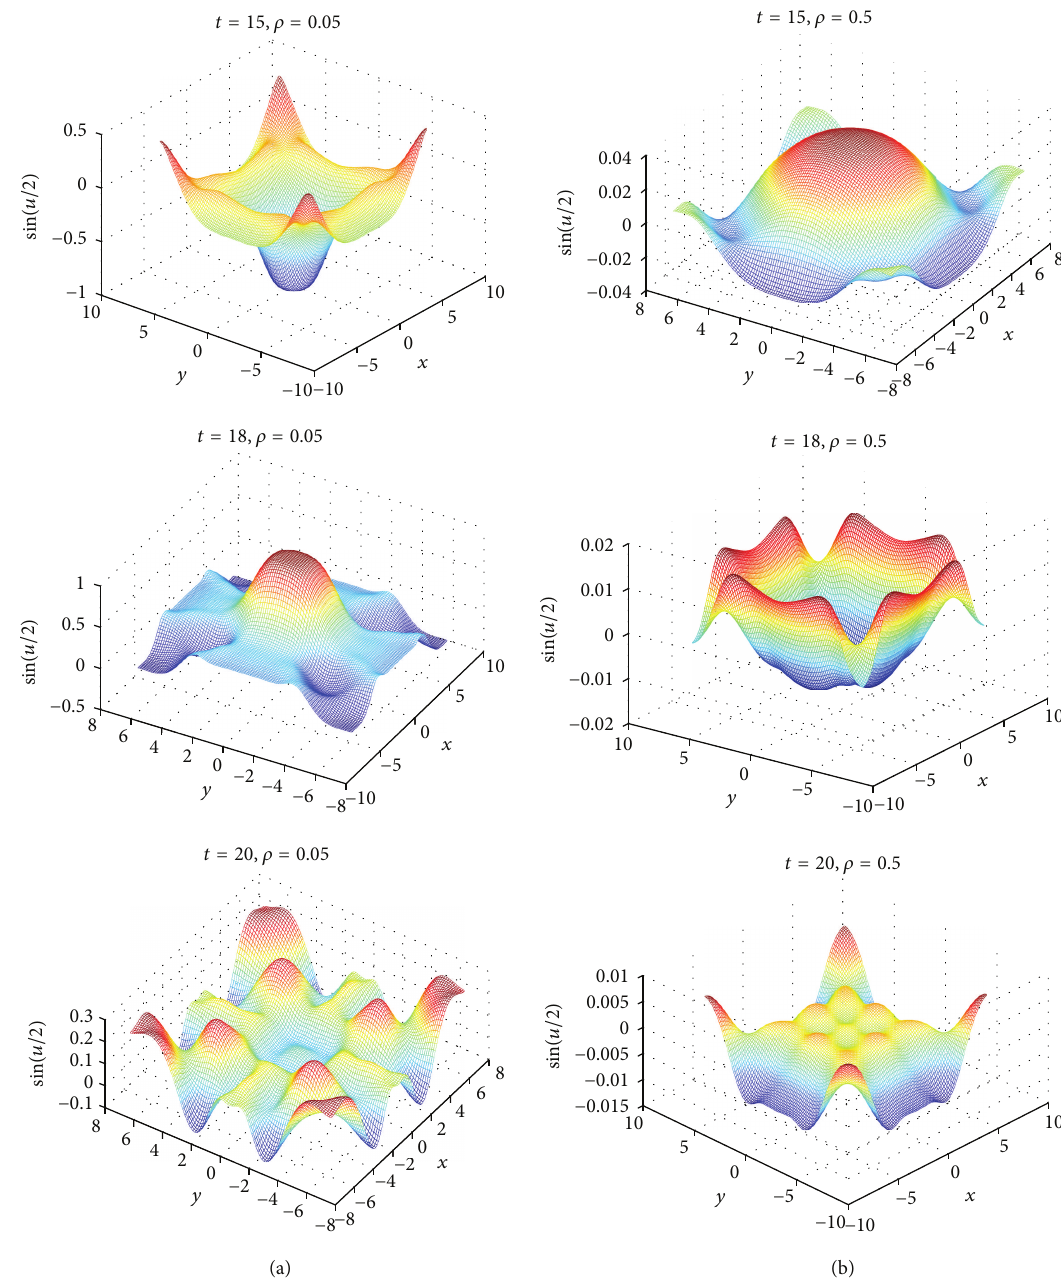
Figure 6: Circular ring solitons solution at 𝑡 = 0, 2.8, 5.6, 8.4, 11.2, 15, 18, 20 with (a) 𝜌 = 0.05 and (b) 𝜌 = 0.5